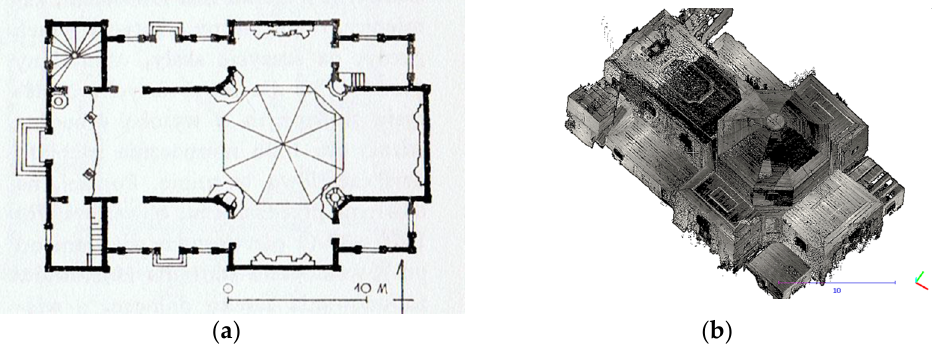
Figure 2. ( a ) Plan of the church of St. Szczepan in Mnichów (source: http://www.zabytkowekoscioly.net, accesed on: 15 October 2021) and ( b ) the scanned shape of the internal structure with a cross plan. In the northern part of the transept a Rococo altar, entirely made of a larch wood, was